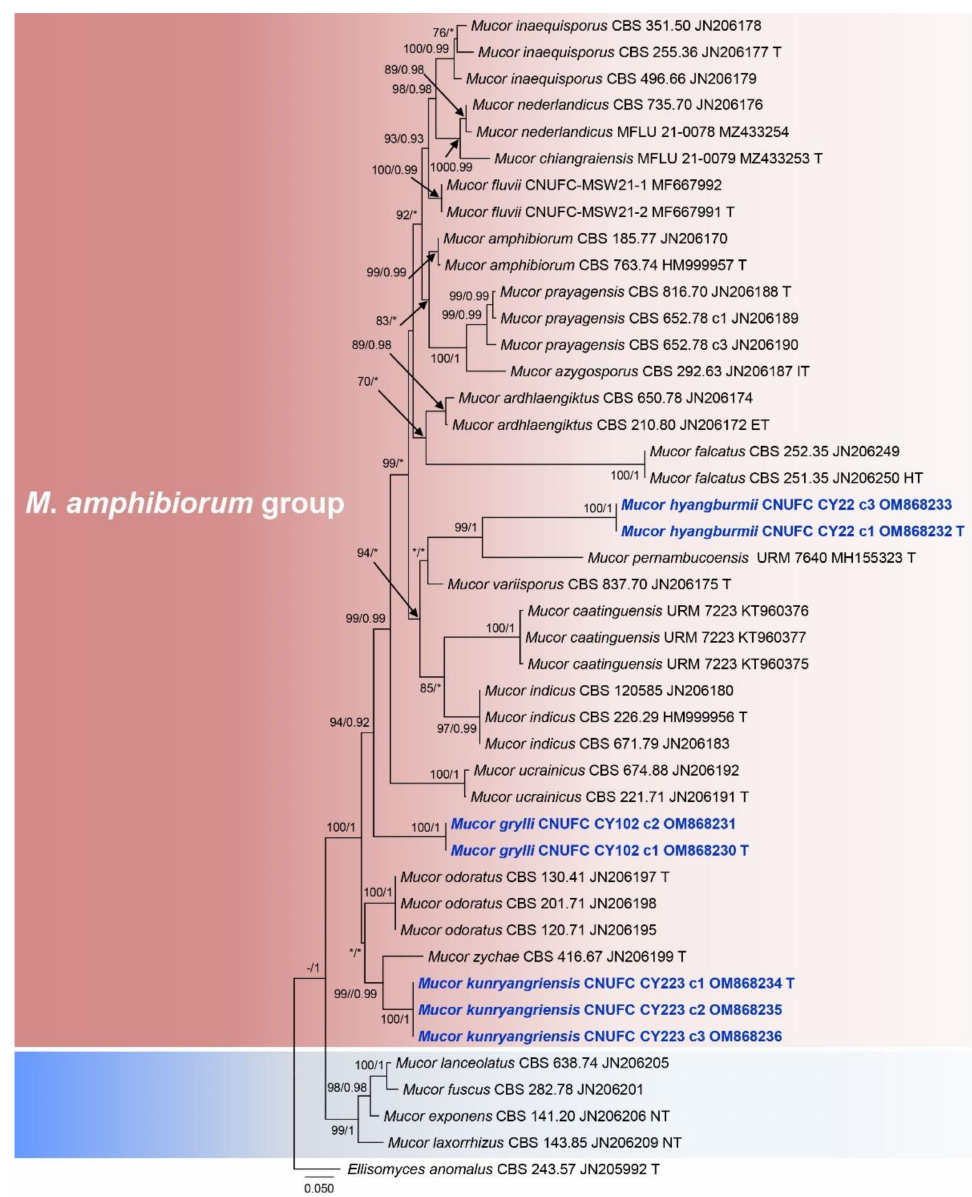
Figure 1. Phylogenetic tree constructed by maximum likelihood analysis of the ITS. The numbers above branches represent maximum likelihood bootstrap percentages (left) and Bayesian posterior probabilities (right). Bootstrap values ≥ 70% and Bayesian posterior probabilities ≥ 0.90 are shown. Bootstrap values lower than 0.90 and 70% are marked with “*”, and absent bootstrap values are marked with “-”. The bar indicates the number of substitutions per position. Ellisomyces anomalus CBS 243.57 was used as outgroup. Type, ex-neotype, ex-holotype, and ex-epitype strains are marked with T, NT, HT, and ET, respectively. Newly generated sequences are in blue bold